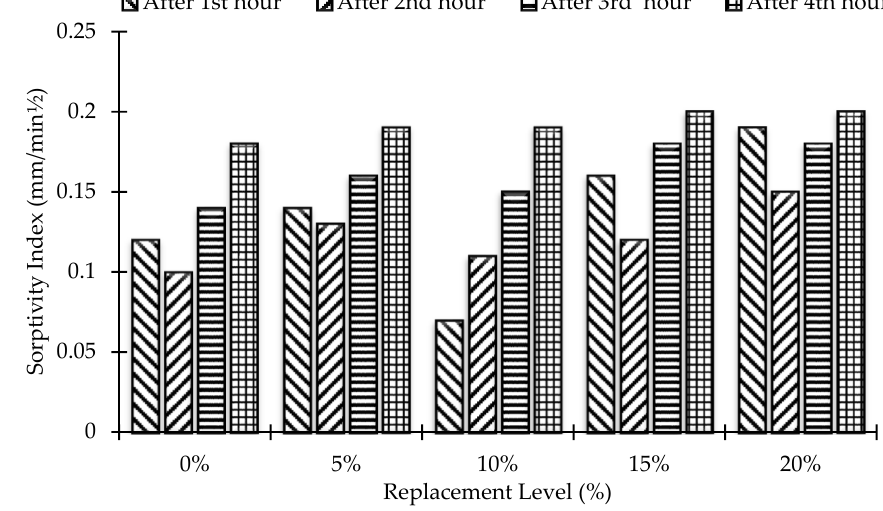
Figure 13. Replacement level versus sorptivity index up to 4